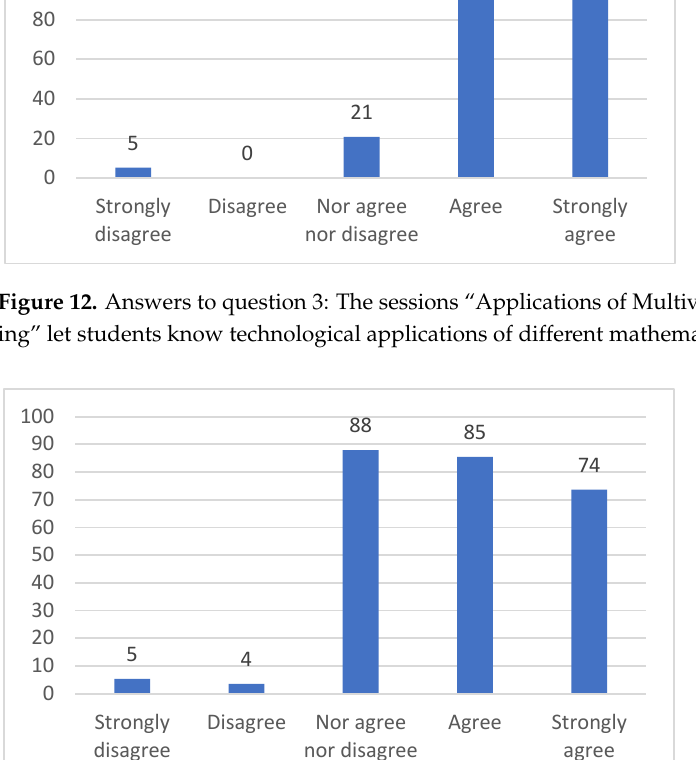
Figure 13. Answers to question 4: The applications of mathematical concepts achieve to increase the motivation to the subject Multivariable Calculus.